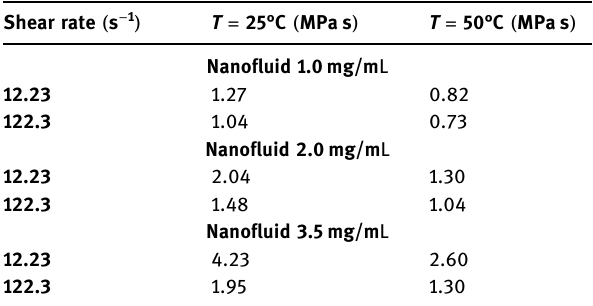
Table 3: Viscosity at varied temperatures and mass